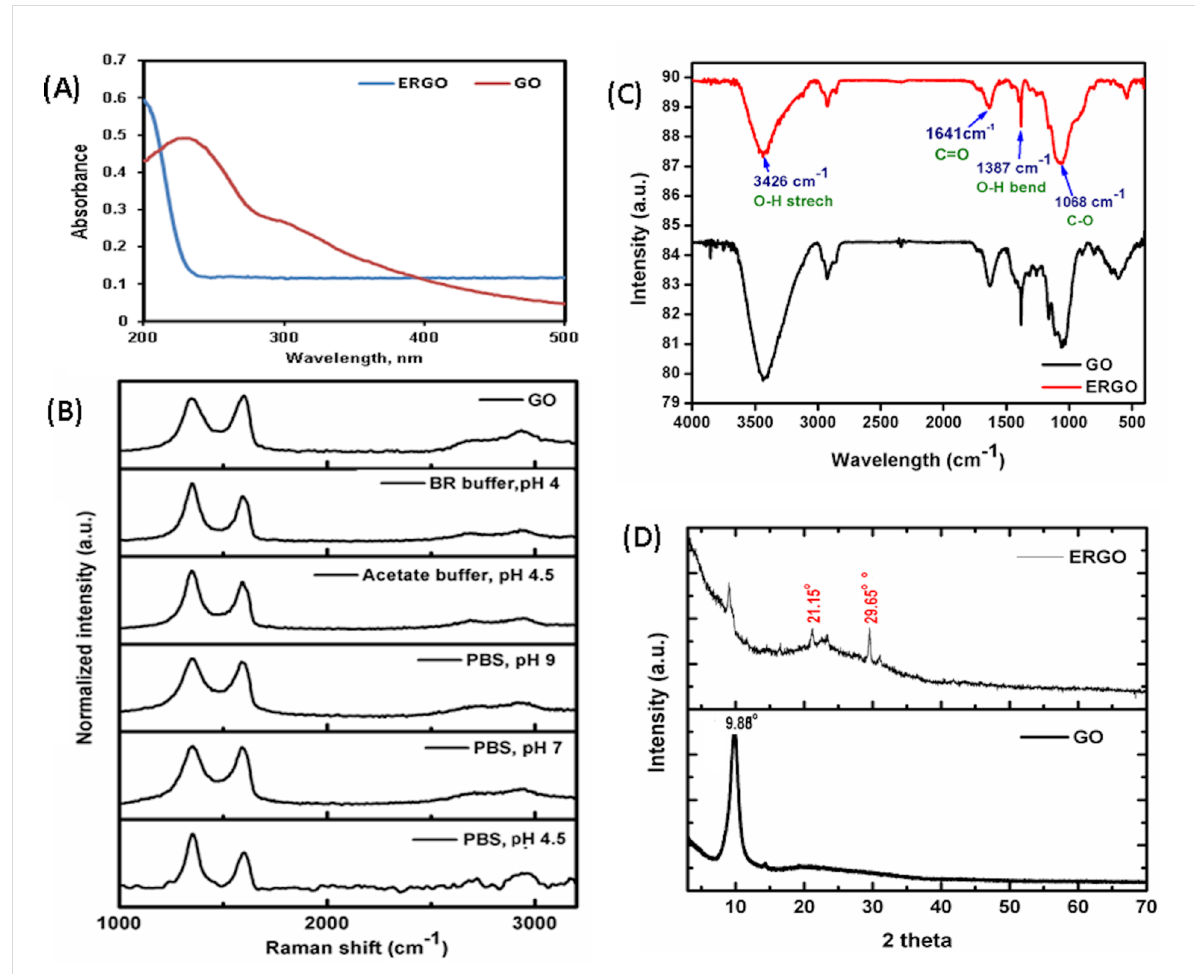
Figure 1: (A) UV–vis spectra of GO and ERGO. (B) Raman spectra for GO to ERGO conversion using different buffers as electrolytes. (C) FTIR spec- tra and (D) XRD patterns of GO and ERGO (PBS pH 4.5).